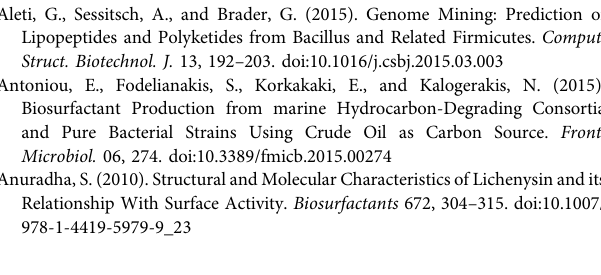
Frontiers in Bioengineering and Biotechnology |